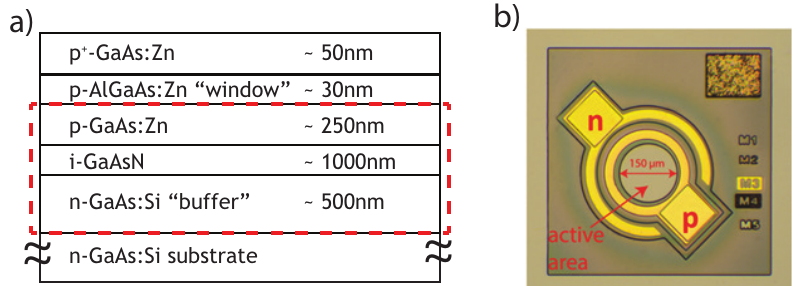
Figure 1. GaAsN-based solar cell: ( a ) epitaxial structure; ( b ) picture of fabricated solar cell (labels M1 to M5 shown on the left are markers used for alignment during lithography